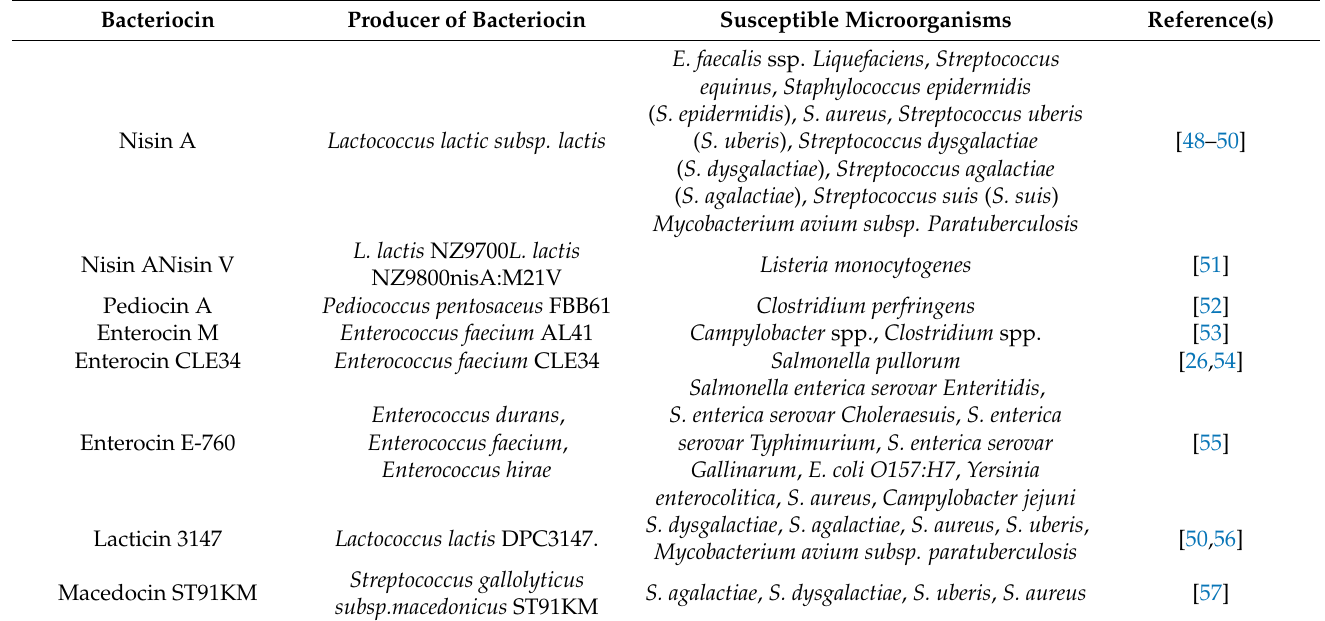
Table 2. Examples of bacteriocins, organisms that produce them and microbes that are susceptible to